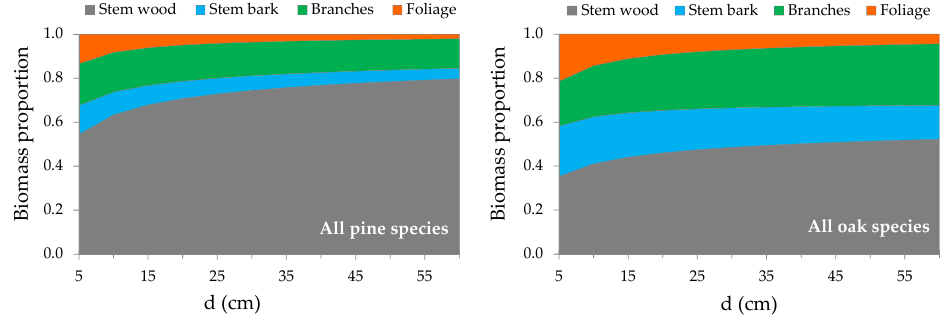
Figure 4. Tree ‐ level biomass allocation patterns of all pine and oak species as a function of individual tree size ( d ), estimated by the proposed biomass equation systems.